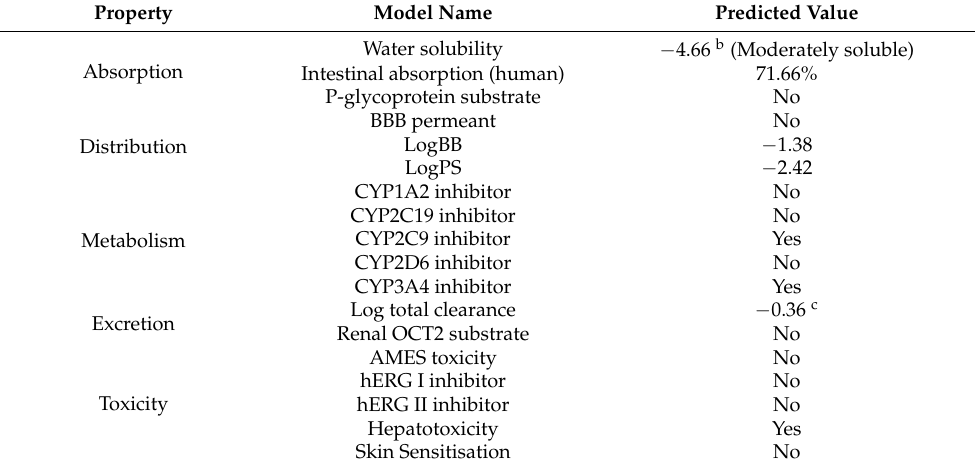
Table 4. In silico pharmacokinetic (absorption, distribution, metabolism, and excretion) and toxicity parameters of bis-thiobarbiturate 11 using pkCSM and SwissADME predictive databases a